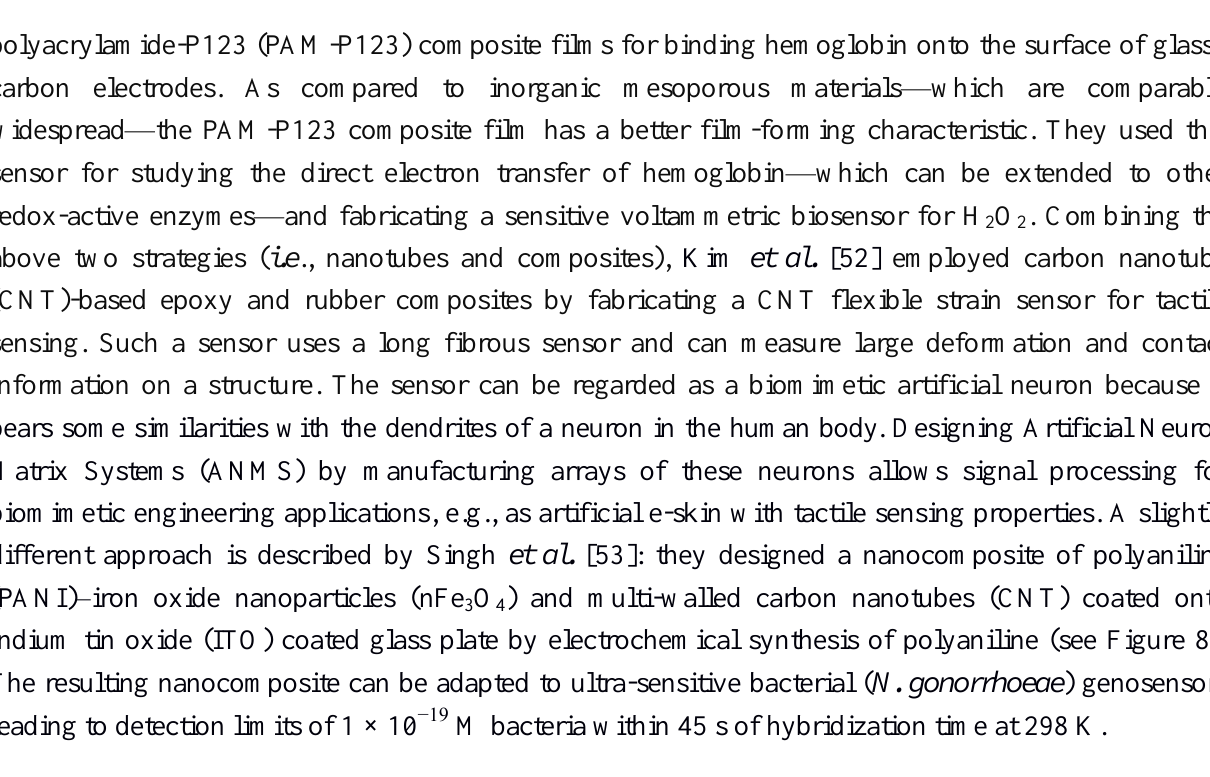
O -CNT nanocomposite and immobilization of 3 4